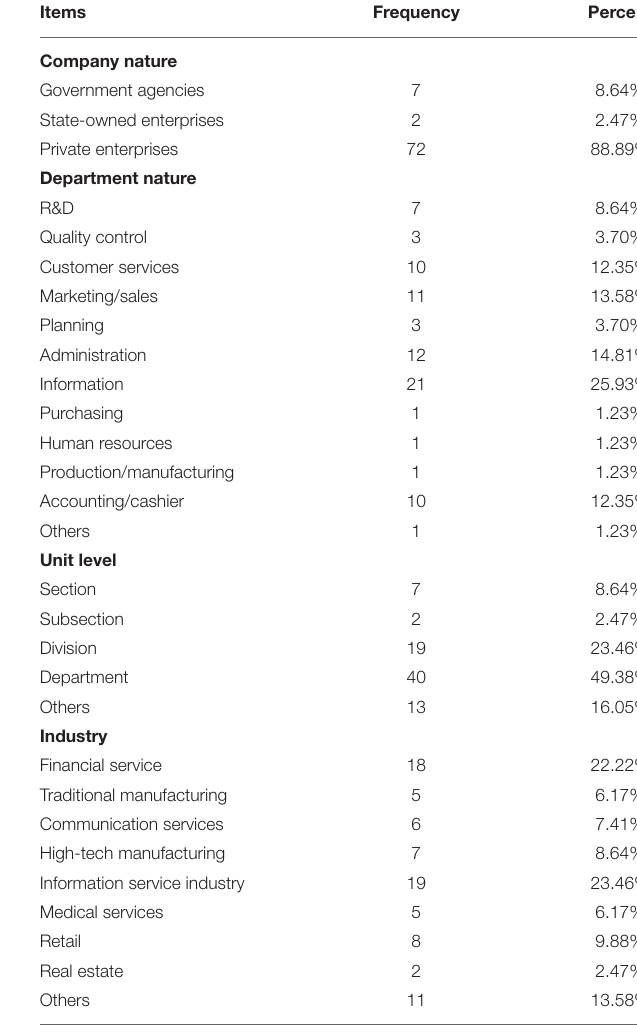
TABLE 3 | Distribution of team-level data ( N =